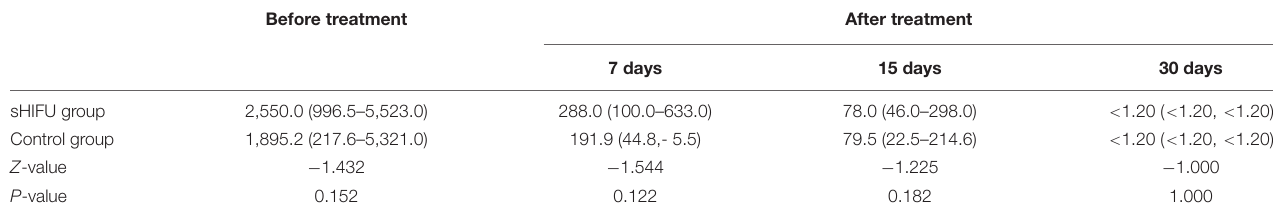
TABLE 2 | Comparison of the serum HCG level changes before and after treatment (mIU/mL). Before